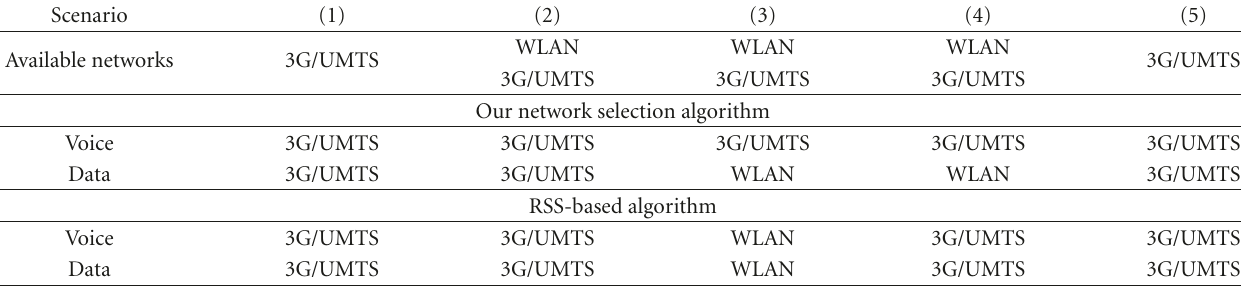
Table 4: Network selection